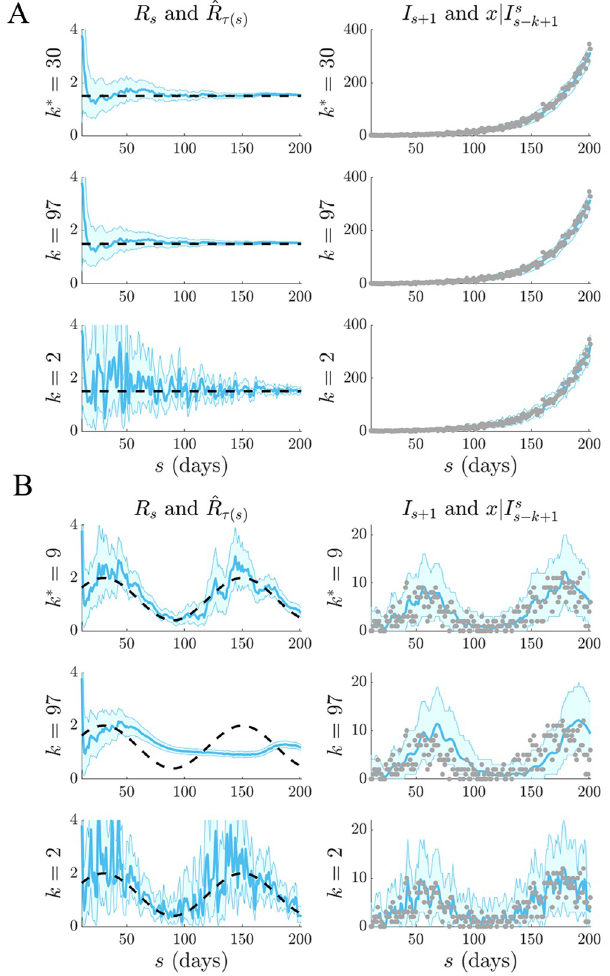
Fig 2. Selection for stable and fluctuating epidemics. Left graphs compare ^ R estimates (blue with 95% confidence t ð s Þ intervals) at the APE window length k � to those when k is set to its upper and lower limits. Right graphs give corresponding one-step-ahead predictions ^ I given the window of data I (blue with 95% prediction intervals). τ ( s − 1) s Dashed lines are the true R s numbers (left) and dots are the true I s counts (right). The panels examine (A) stable (constant) and (B) periodically varying changes in R s